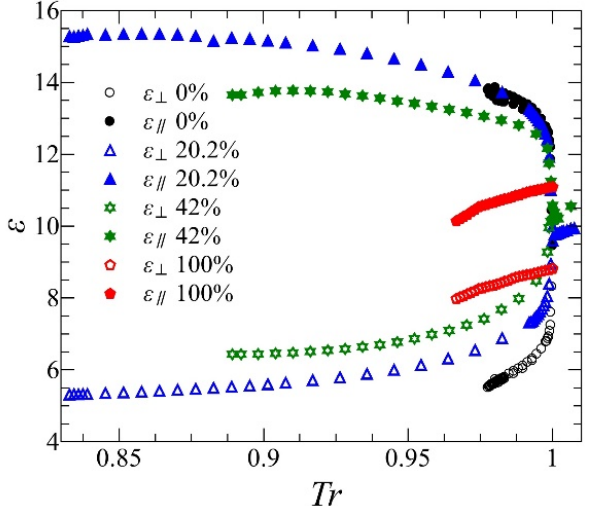
Figure 8. Dielectric permittivities of the mixtures as a function of the reduced temperature T r and for different fraction 𝜙 of CB7CB. Closed symbols represent the parallel dielectric permittivity 𝜀 ∥ whereas open symbols indicate the perpendicular dielectric permittivity ( 𝜀 (cid:2884) ). Errors bars are smaller than the size of the symbols.